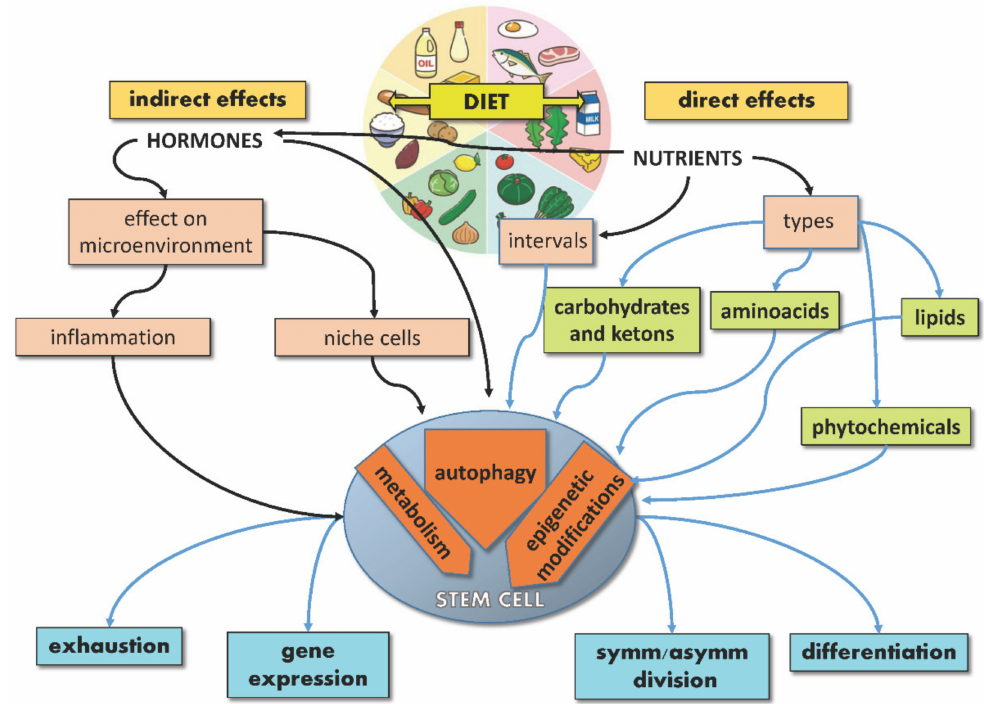
Figure 1. Schematic illustration showing direct and indirect effects of diet on stem cells. SC features regulated by nutrients include symmetric/asymmetric division